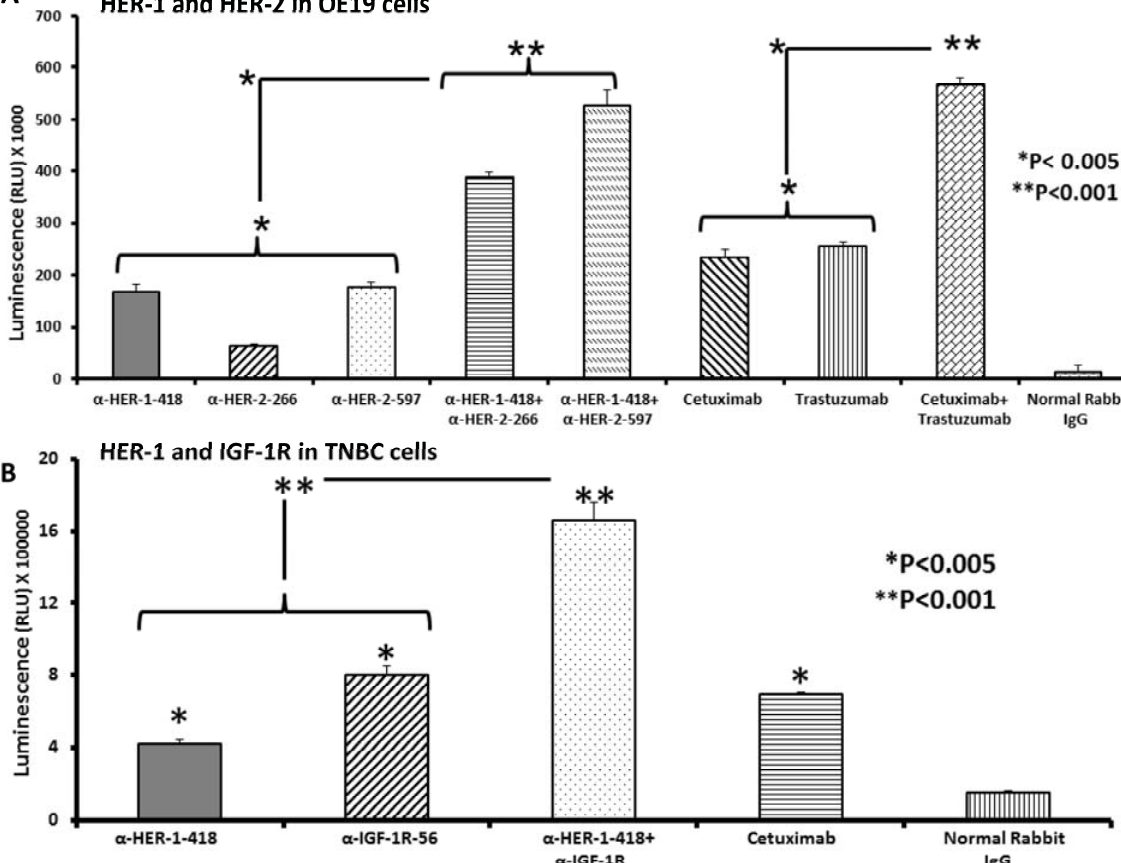
Figure 4. Effects of co-targeting HER-1 and HER-2 or HER-1 and IGF-1R on induction of apoptosis in EC or TNBC . OE19 or MDA-MB-231 cancer cells were plated in 96-well plates and treated with peptide vaccine antibodies for 24 h prior to cell lysis. Apoptosis (directly proportional to amount of luminescence produced) was measured using the Caspase Glo 3/7 kit (Promega, Madison, WI, USA). After 24 h of treatment, caspase glo reagent was added, and plates were incubated for 3 h before being read on a luminometer. Normal rabbit IgG was used as a negative control; cetuximab and trastuzumab were positive controls. Results are representative of two independent experiments performed in triplicate. Error bars represent SD of the mean. In EC cells ( A ), single peptide vaccine antibody treatment significantly increased apoptosis over negative control (* p < 0.005). The combinations of anti-HER-1-418 and HER-2-266 or anti-HER-1-418 and HER-2-597 showed significantly higher levels of apoptosis than single treatment alone (* p < 0.005). TNBC cells ( B ) showed single peptide vaccine antibody treatment significantly increased apoptosis over negative control (* p < 0.005), and the combination of anti-HER-1-418 and anti-IGF-1R-56 showed significantly higher levels of apoptosis compared to single treatment alone (** p <